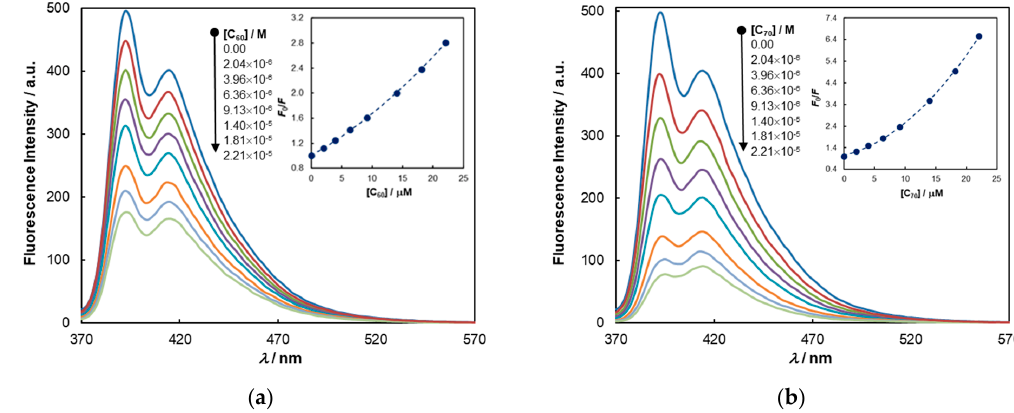
Figure 4. Emission spectra of bis ‐ ( p ‐ H ‐ calix ‐ triprop) ‐ 2,7 ‐ CBZ ( 5 ) (6.0 × 10 − 7 M in toluene; λ exc = 357 nm) after successive additions (2.04 × 10 − 6 – 2.21 × 10 − 5 M) of fullerene C 60 ( a ) and C 70 ( b ). Insets: plots of the changes in the ratio of fluorescence intensity of 5 vs. [C 60 ] and [C 70 ].